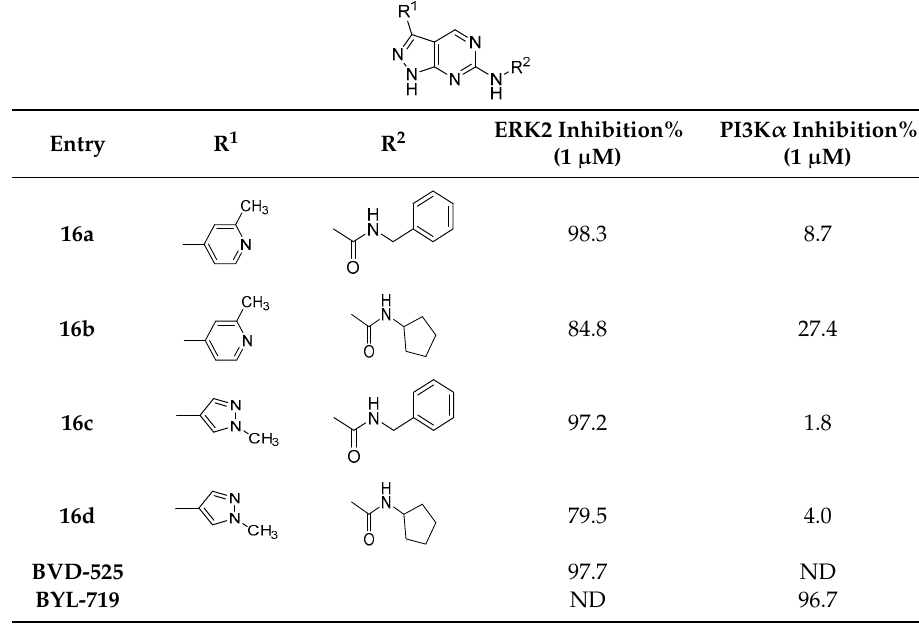
Table 1. In vitro ERK 2 and PI3K α inhibitory activities of compounds 16a ~1 6d.